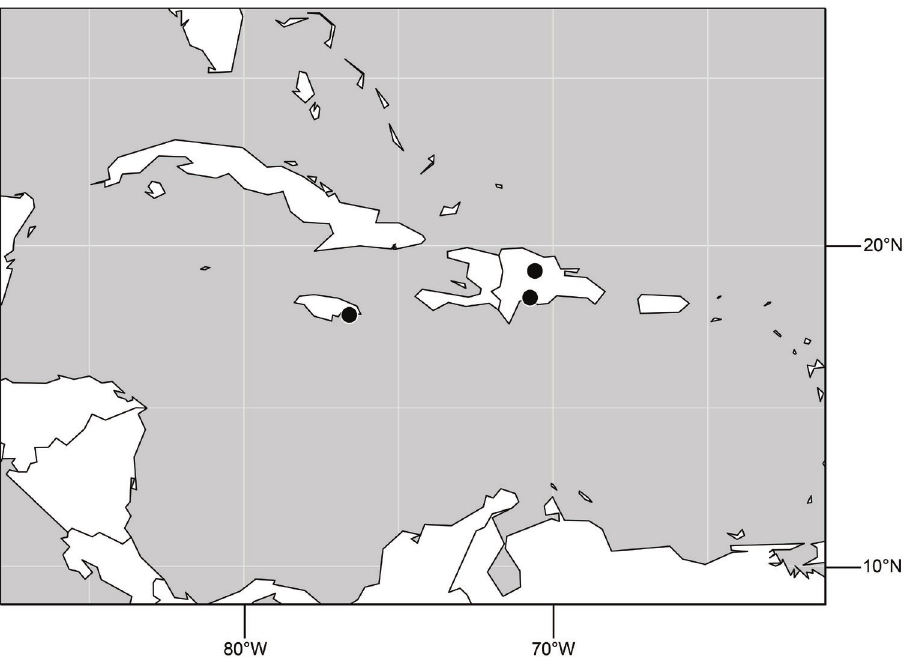
Figure 166. Distribution map of Hydrochasma edmistoni sp.